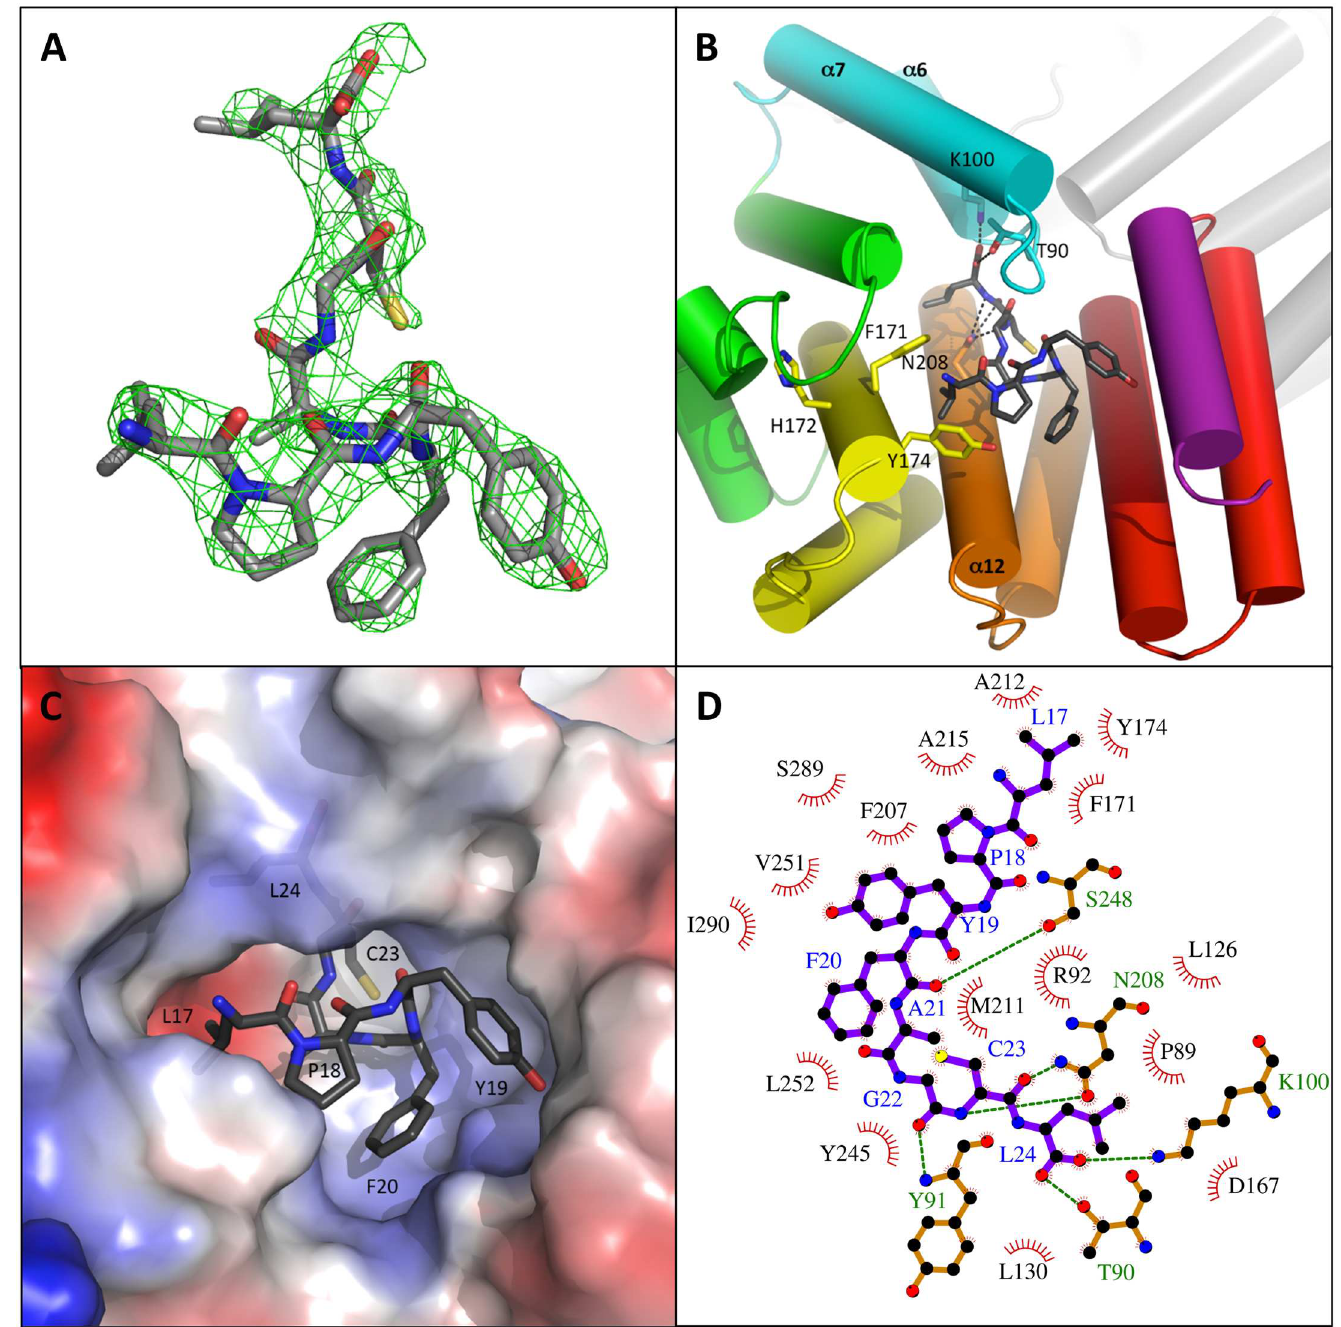
Fig 2. Peptide binding mode. A–Electrondensity map of the bound peptide. The Fo-Fc map, calculatedby a simulatedannealingprotocol without peptidein the structure, is shown contoured at 1 σ as a green grid with the peptidein sticks colored by atom type. B–Peptide binding mode. The protein is shown as cartoon colored by spectrum as chain B in Fig 1A. The boundpeptideis shown as sticks colored by atom type. ResiduesK100, T90 and N208 H- bondingwith the boundpeptideare highlightedin sticks as well as residues F171, H172 and Y174. C–Peptide-binding pocket. ComR is shown as electrostatic surface coloredby potential from blue (positive) to red (negative). The bound XIP is shown as sticks colored by atom type and its residuesare labeled. D–Schematic drawing of the ComR-XIP interaction . The XIP peptideis shown as purplesticks with blue labels.The polar ComR residues directly interactingwith XIP are shown as orangesticks with green labels. Hydrogenbondsare highlighted by green dashedlines. The hydrophobic ComR residues forming the peptidebindingpocket are shown as red arcs with spokes radiatingtowards the ligand. The figure has been generatedusing Ligplot